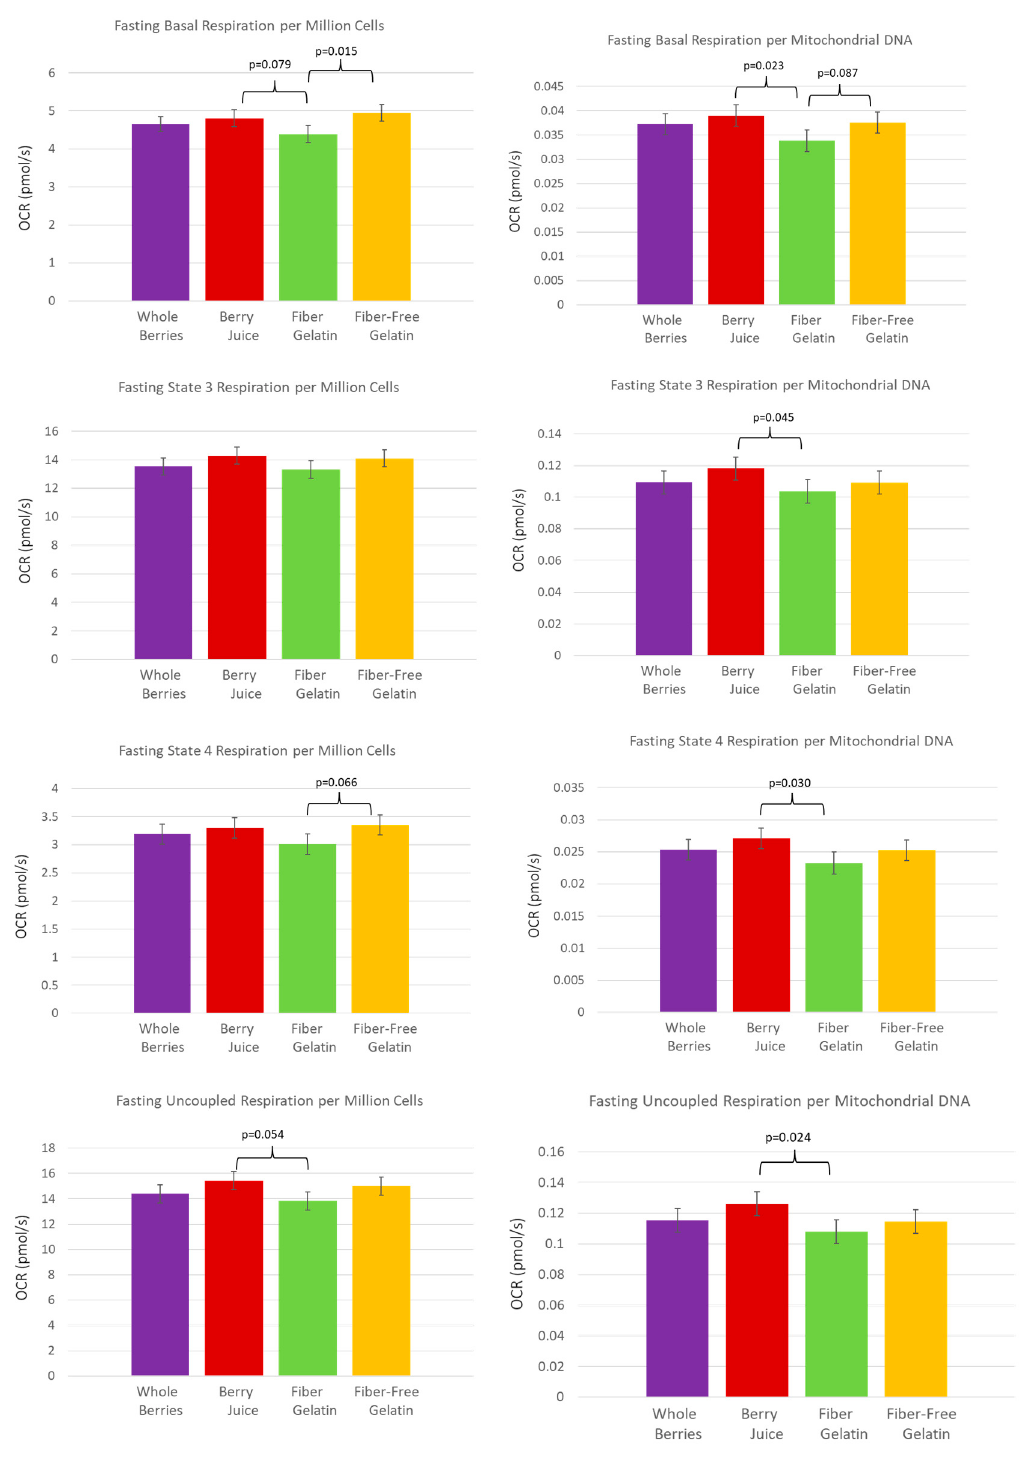
Figure 2. PBMC oxygen-consumption rate in the fasted state after subjects consumed whole berries, berry juice, fiber-enriched gelatin, or fiber-free gelatin for one week.